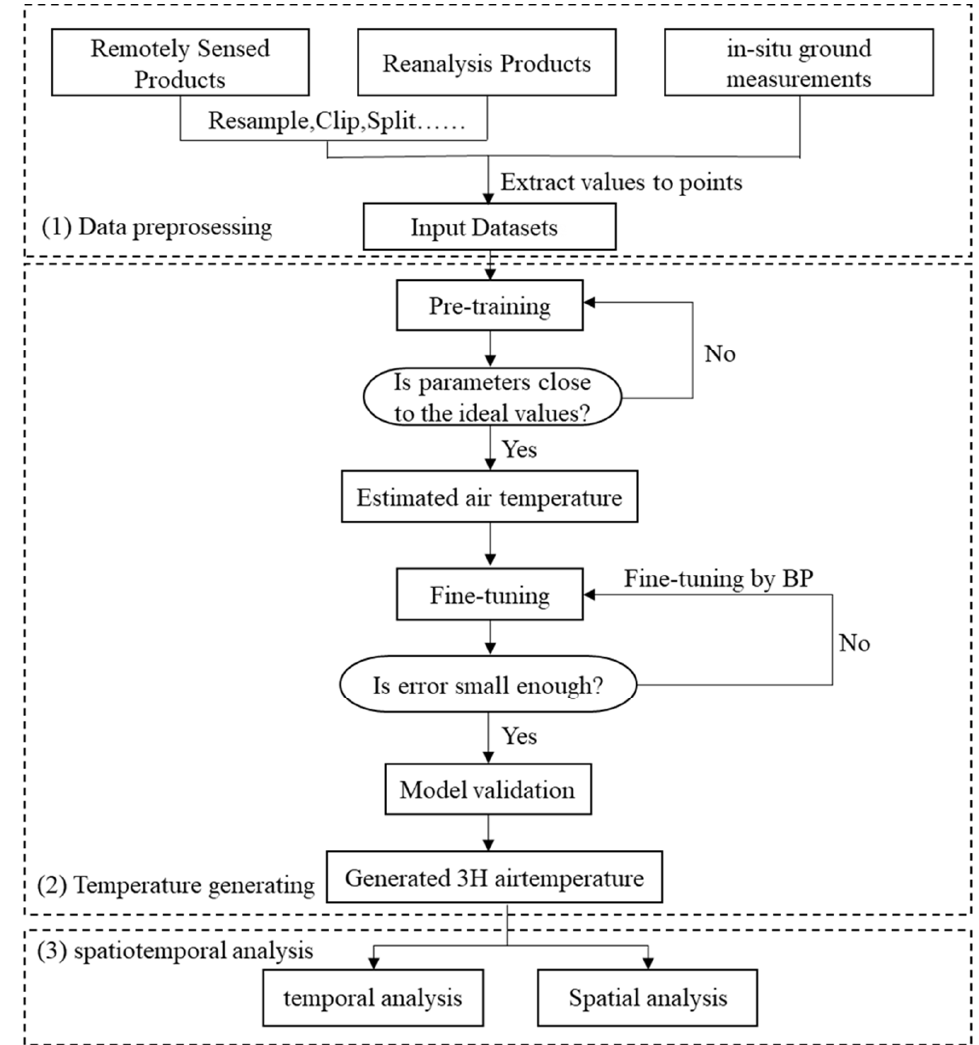
Figure 2. The 3H urban temperature mapping methodology of this study.